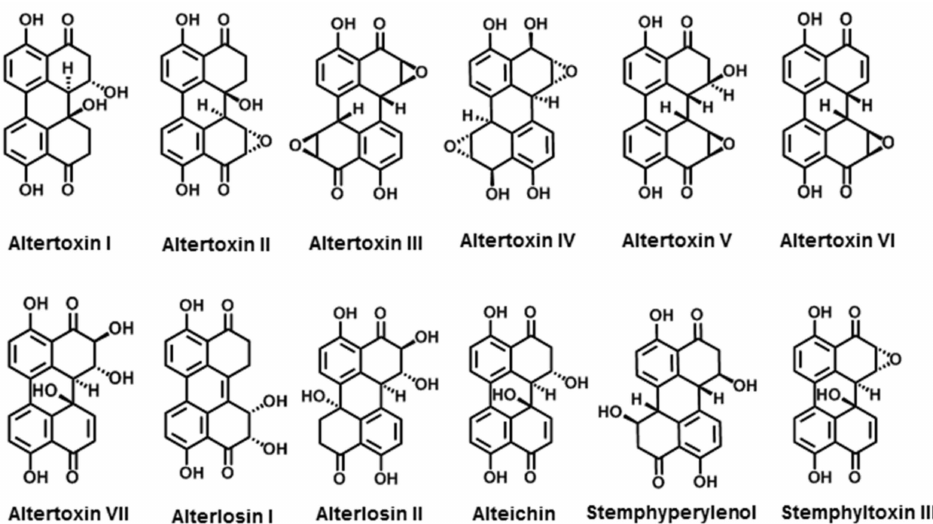
Figure 7. Chemical structures of Alternaria NHSTs belonging to perylenequinone